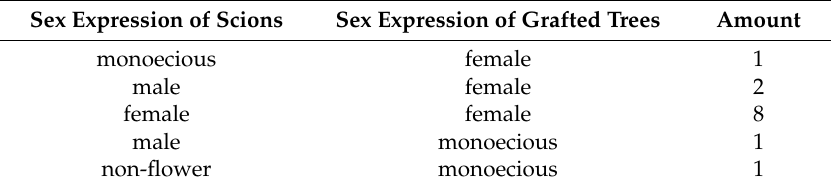
Figure 3. Characteristics of the grafted Pistacia chinensis . Female inflorescences on a female grafted tree ( a ); and mixed inflorescences on a monoecious grafted tree ( b ). Table 3. Sex expression of grafted monoecious Pistacia chinensis.